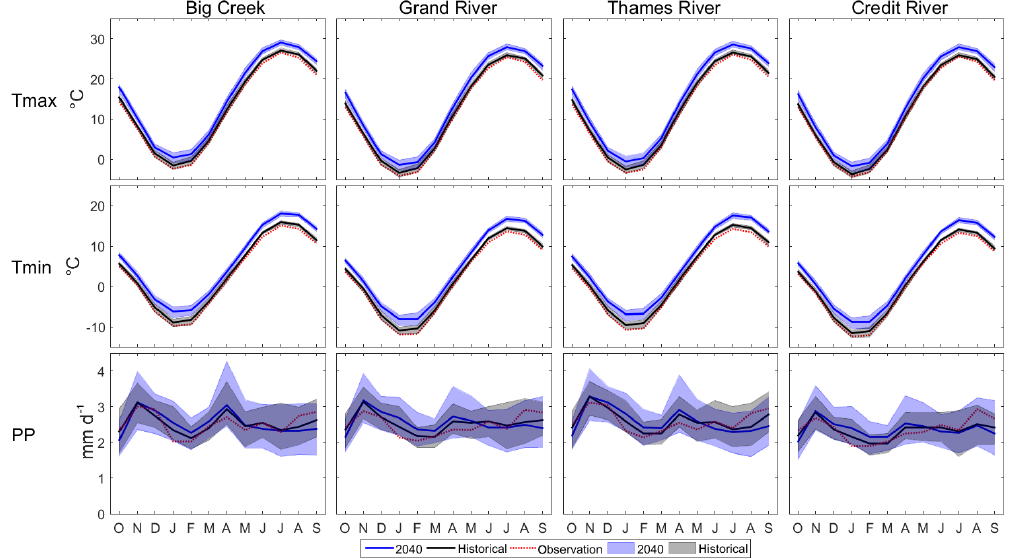
Figure 5. CRCM5 50-member range and average bias-corrected temperature and precipitation amounts for the historical and the 2040s periods, together with the observed temperature and